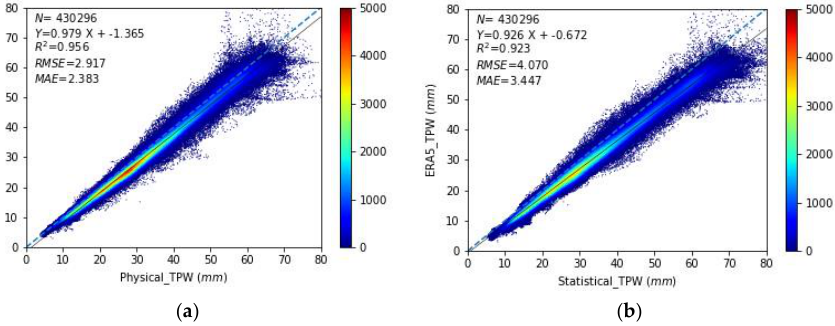
Figure 8. Scatter plot of TPW over oceans from ( a ) physical and ( b ) statistical descending orbit data collocated with ERA5 TPW in 2018.